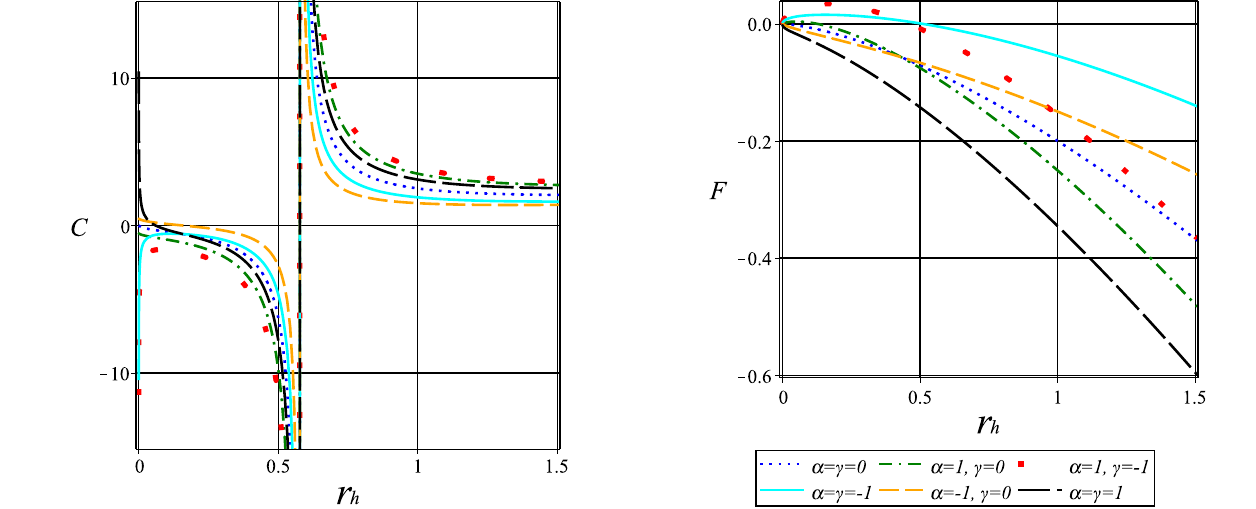
Fig. 9 Helmholtz free energy of the LMP solution of HL black hole in flat space for l = 1 and a =